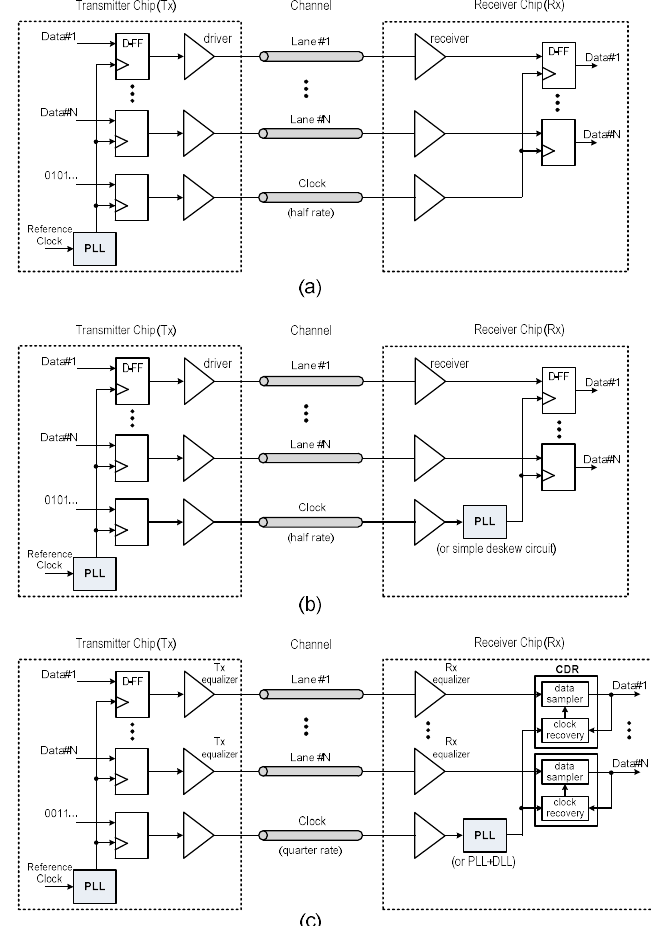
Figure 2. Typical multi-lane high-speed source synchronous serial-link architecture ( a ) without PLL ( b ) with PLL ( c ) with equalizers, PLLs, and